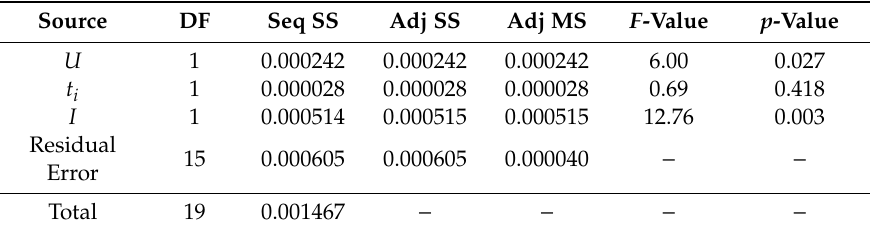
Table 8. ANOVA for the taper angle ( tap α ).